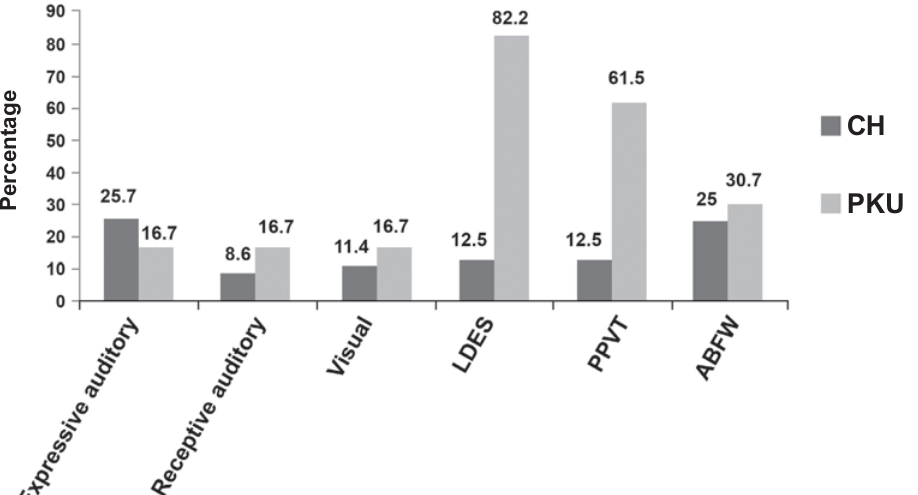
Figure 4- Percentage of children with alterations in the abilities of the ELMS, LDES, PPVT and ABFW